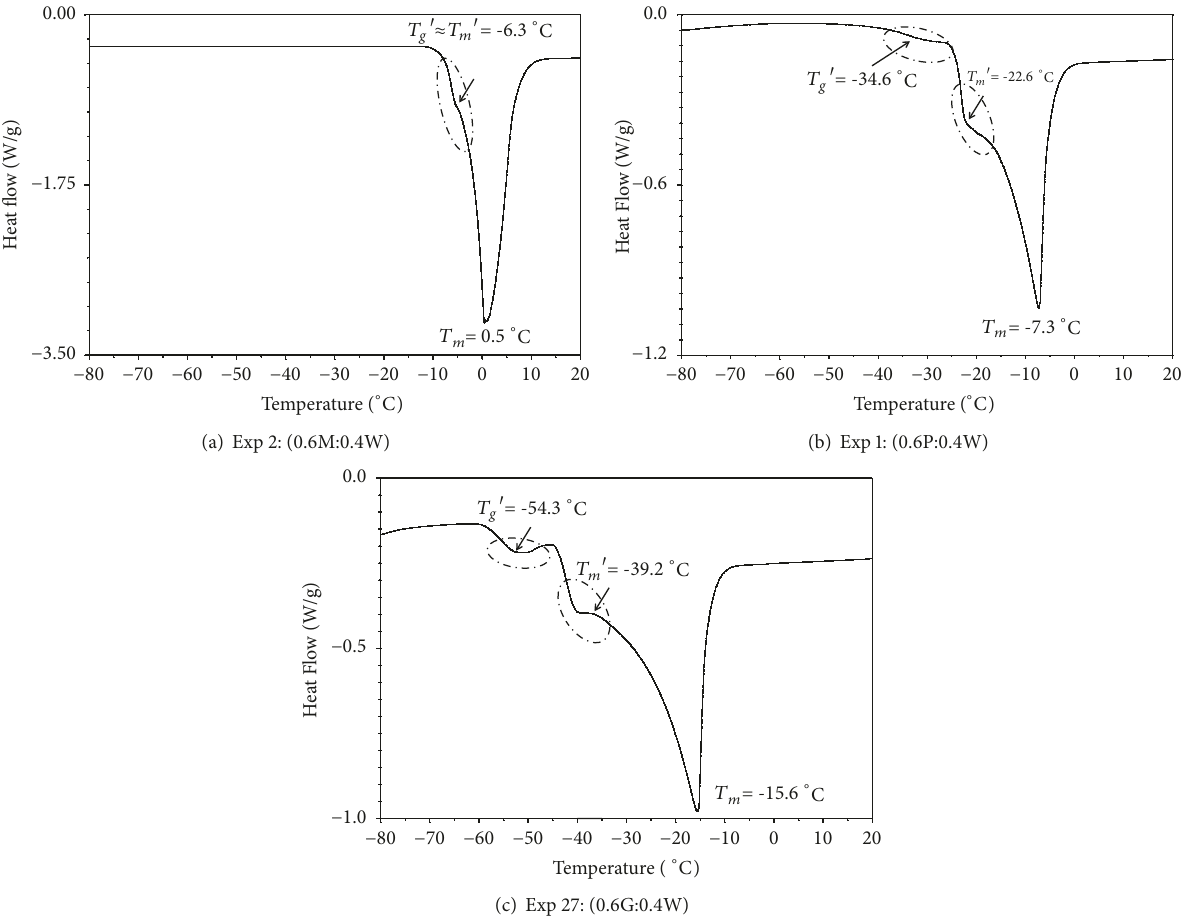
Figure 1: Phase and state transition analysis of frozen cryoprotectant solutions containing pure components prepared at a moisture content 󸀠 – 1) ∘ C: (a) Exp 2, (b) Exp 1, and (c) Exp 27. = 0.4 ) and annealed for 30 min at ( 𝑇 of 40% wet basis ( 𝑋 W m